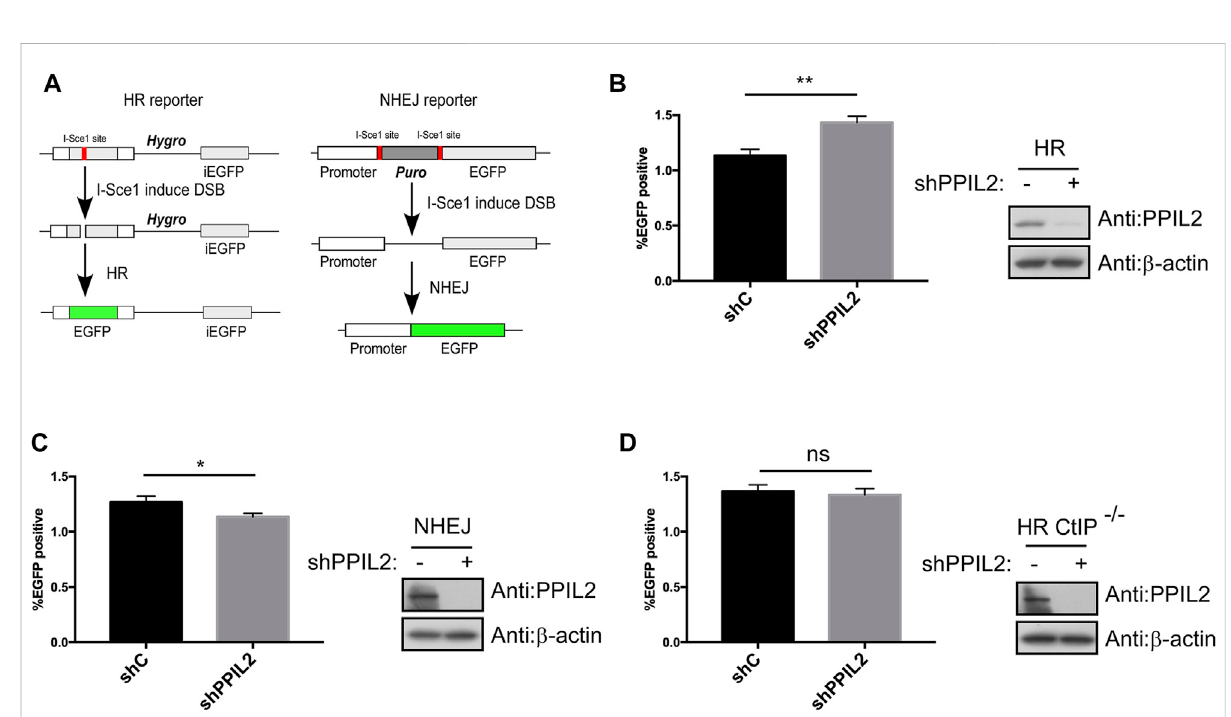
FIGURE 2 PPIL2 regulates HR in a CtIP-dependent manner. (A) Schematic of the EGFP-HR and EGFP-NHEJ reporter system. (B,C) Knockdown of PPIL2 promotes HR and inhibits NHEJ. EGFP-HR, and EGFP-NHEJ reporters were transfected into U2OS cells, and then were infected with shRNA control (shC) or shPPIL2, followed by infection with lentivirus-I-sceI for 16 h. After 48 h, the cells were collected, and GFP-positive cells were recorded by FACS. Left, therelative HR or NHEJ ef fi cacy was quanti fi ed. Right, western blotting shows the ef fi ciency of shPPIL2. (D) PPIL2 does not affect HR after CtIP depletion. EGFP-HR was performed in U2OS CtIP-depleted cells using the same method as the EGFP-HR reporter. Top, the relative HR ef fi cacy was quanti fi ed. Bottom, western blotting shows the ef fi ciency of shPPIL2. The data represent the means of three